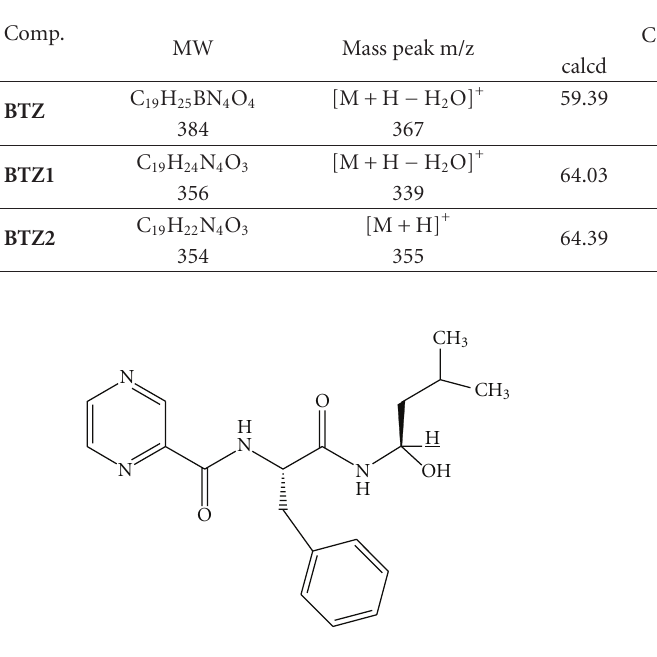
Figure 5: (S)-N-(1-(3-methylbutanamido)-1-oxo-3- phenylpropan-2-yl)pyrazine-2-carboxamide ( BTZ2